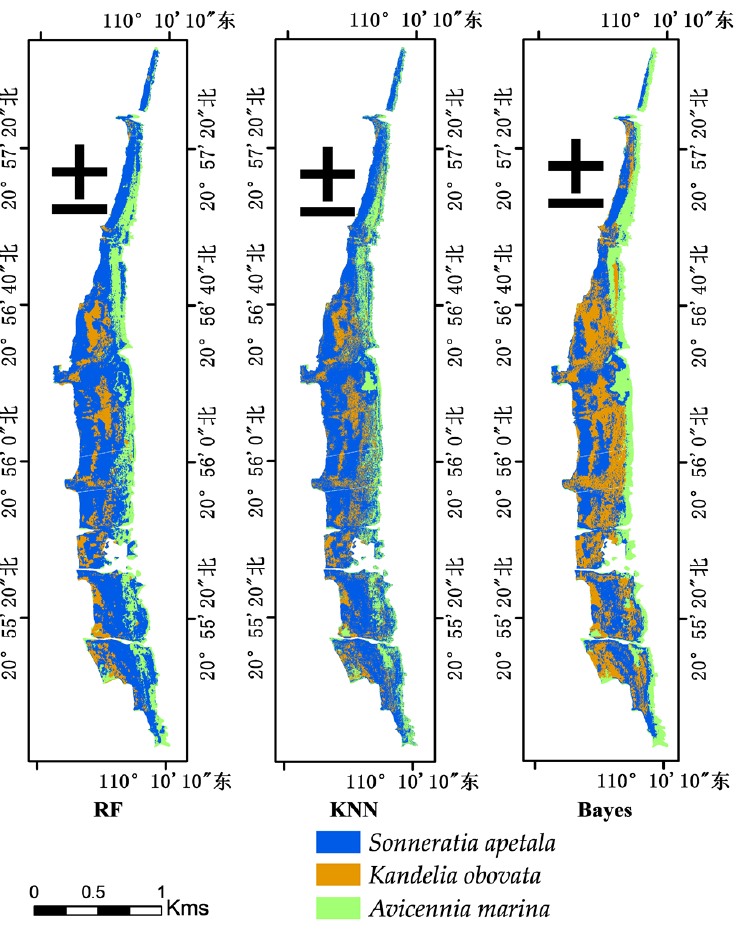
Figure 6. Results of different methods of classification. Table 9. Total accuracy and Kappa coefficient of 10 groups of experiments based on 4 methods.